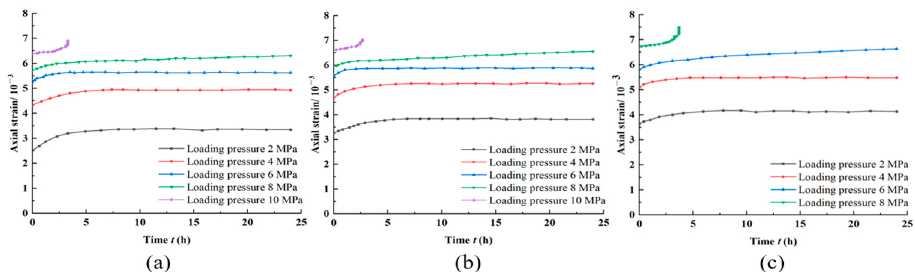
Figure 12. Creep deformation curves of different porosity grades under the same pore water pressure; ( a ) the porosity interval is 5~10%; ( b ) the porosity interval is 10~15%; ( c ) the porosity interval is 15~20%.